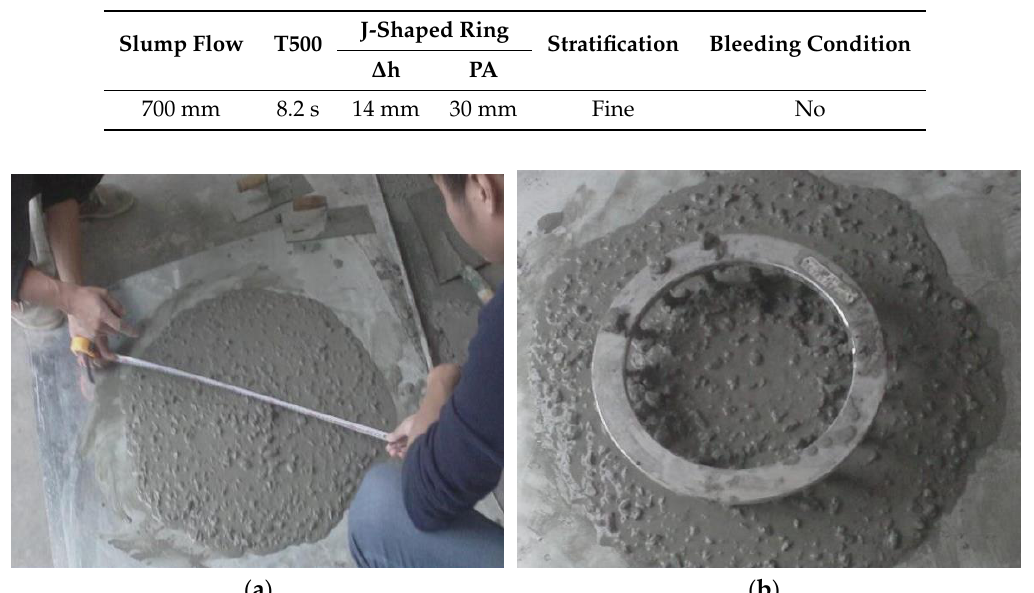
Figure 3. The basic workability test of S 0 SCC. ( a ) Slump flow test (SF = 700 mm); ( b ) J-ring test (SF J = 670 mm).